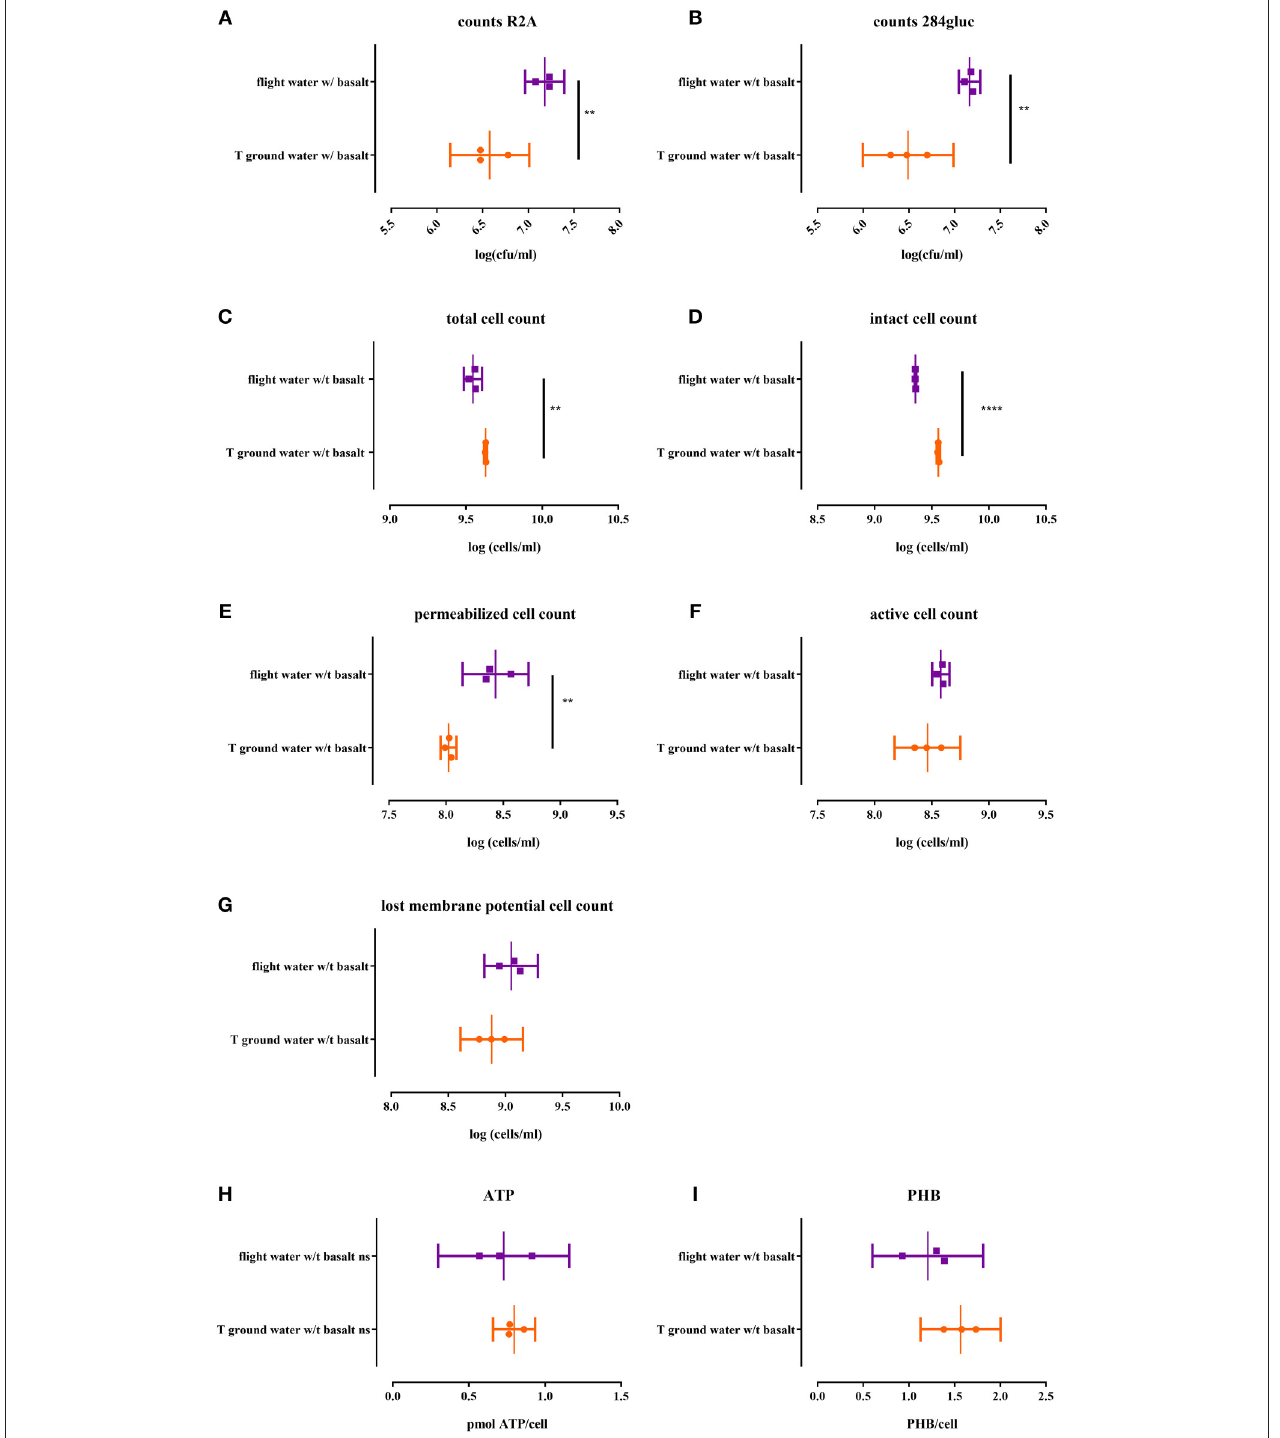
FIGURE 4 | Cell physiology, cultivability ATP and PHB levels of the CH34 biofilm fraction after sonication of both flight and ground samples with basalt, analyzed after the three month flight experiment. All replicates are represented by a dot; the mean is indicated as a line as well as the 95% confidence interval between brackets. For the statistical analysis, one way ANOVA was used with Tukey post testing (alpha = 0.05). Significances are indicated with (*) (with: ** p < 0.01 and **** p < 0.0001). P -values as well as significance are also reported in Supplementary Table S2 . Samples were plated on R2A (A) and 284MM agar (B) to determine cultivability of CH34 biofilm cells. The total cells number (SG) (C) as well as the number of intact cells (SGPI) (D) , permeabilizated (SGPI) (E) , active (cFDA) (G) and cells which have lost their membrane potential [DIBAC 4 (3)] (F) were measured. ATP (H) and PHB (I) content of the cells was also measured.